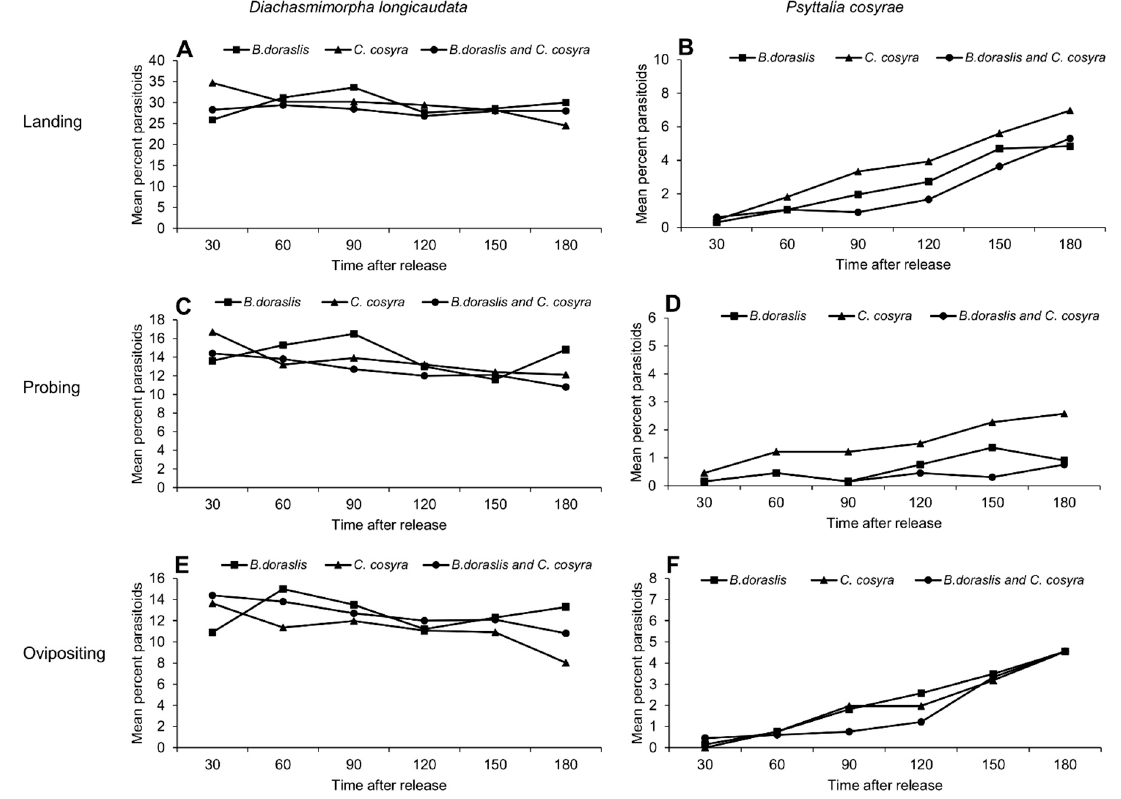
Figure 1. Activity trend of ( A ) Diachasmimorpha longicaudata and ( B ) Psyttalia cosyrae landing on the oviposition unit; ( C ) Diachasmimorpha longicaudata and ( D ) Psyttalia cosyrae probing on the oviposition unit; and ( E ) Diachasmimorpha longicaudata and ( F ) Psyttalia cosyra ovipositing on the oviposition unit over time at 30-min time intervals.